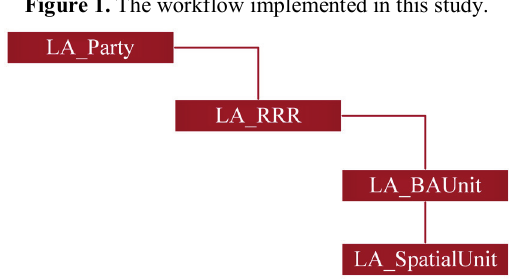
Figure 2. Basic classes of LADM (ISO,